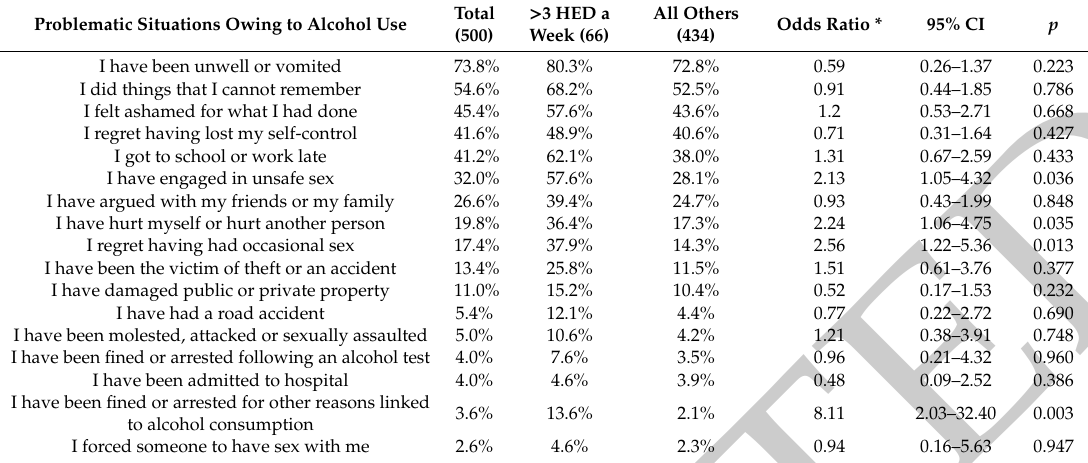
Table 2. Problematic situations owing to alcohol use: profile of subjects with “more than three HED a week” versus all others.